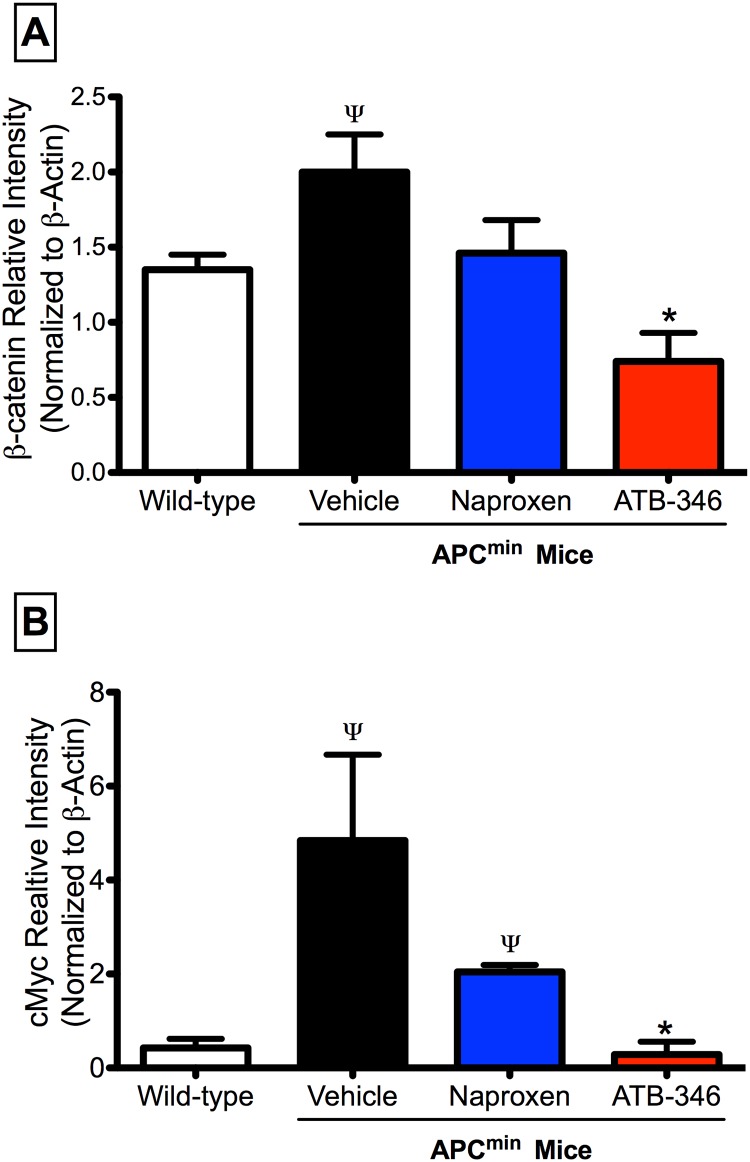
Treatment with ATB-346 reduced intestinal β-catenin and cMyc levels in APCMin/+ mice.Expression of both β-catenin (panel A) and cMyc (panel B) were significantly elevated in colonic tissue from APCMin/+ mice as compared to wild-type mice. Treatment of APCMin/+ mice with ATB-346 (14.5 mg/kg) significantly reduced β-catenin and cMyc expression to levels comparable to those in wild-type mice, while naproxen treatment (10 mg/kg) reduced cMyc but not β-catenin. Tissue samples were collected from the mice at 14 weeks of age, while drug treatment occurred in the 6th and 7th weeks of age. Each bar represents the mean ± SEM for at least 4 mice (p<0.05 vs. wild-type mice; ψp<0.05 vs. wild type. *p<0.05 vs. naproxen-treated).